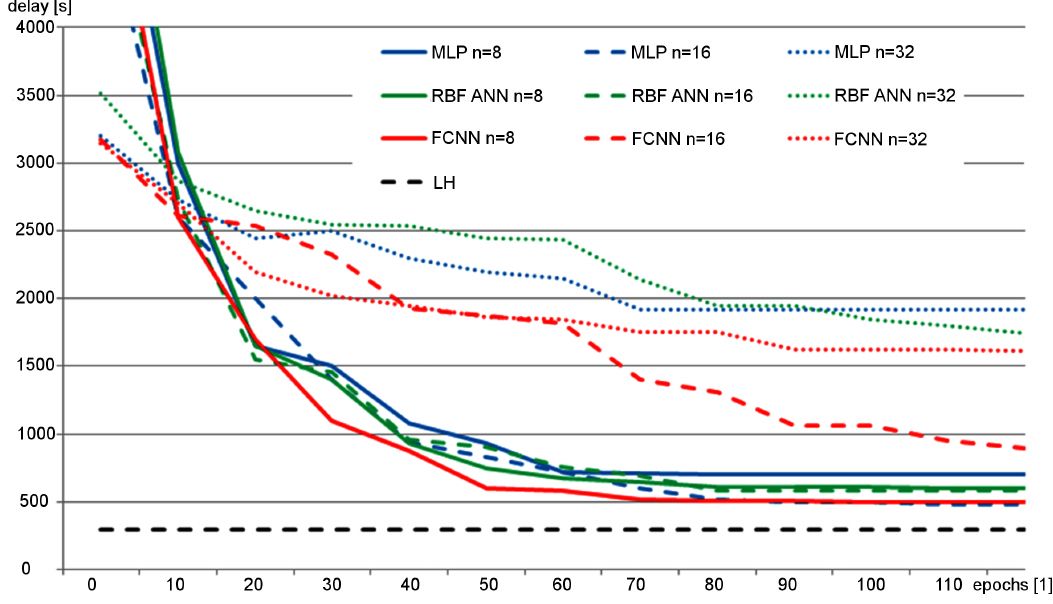
Figure 12. Vehicle delay observed during neuroevolution of ANNs with various